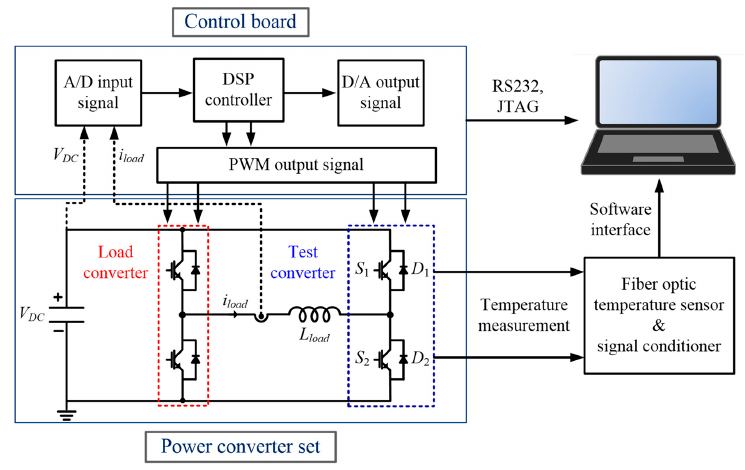
Figure 5. Configuration of the proposed hardware simulator.